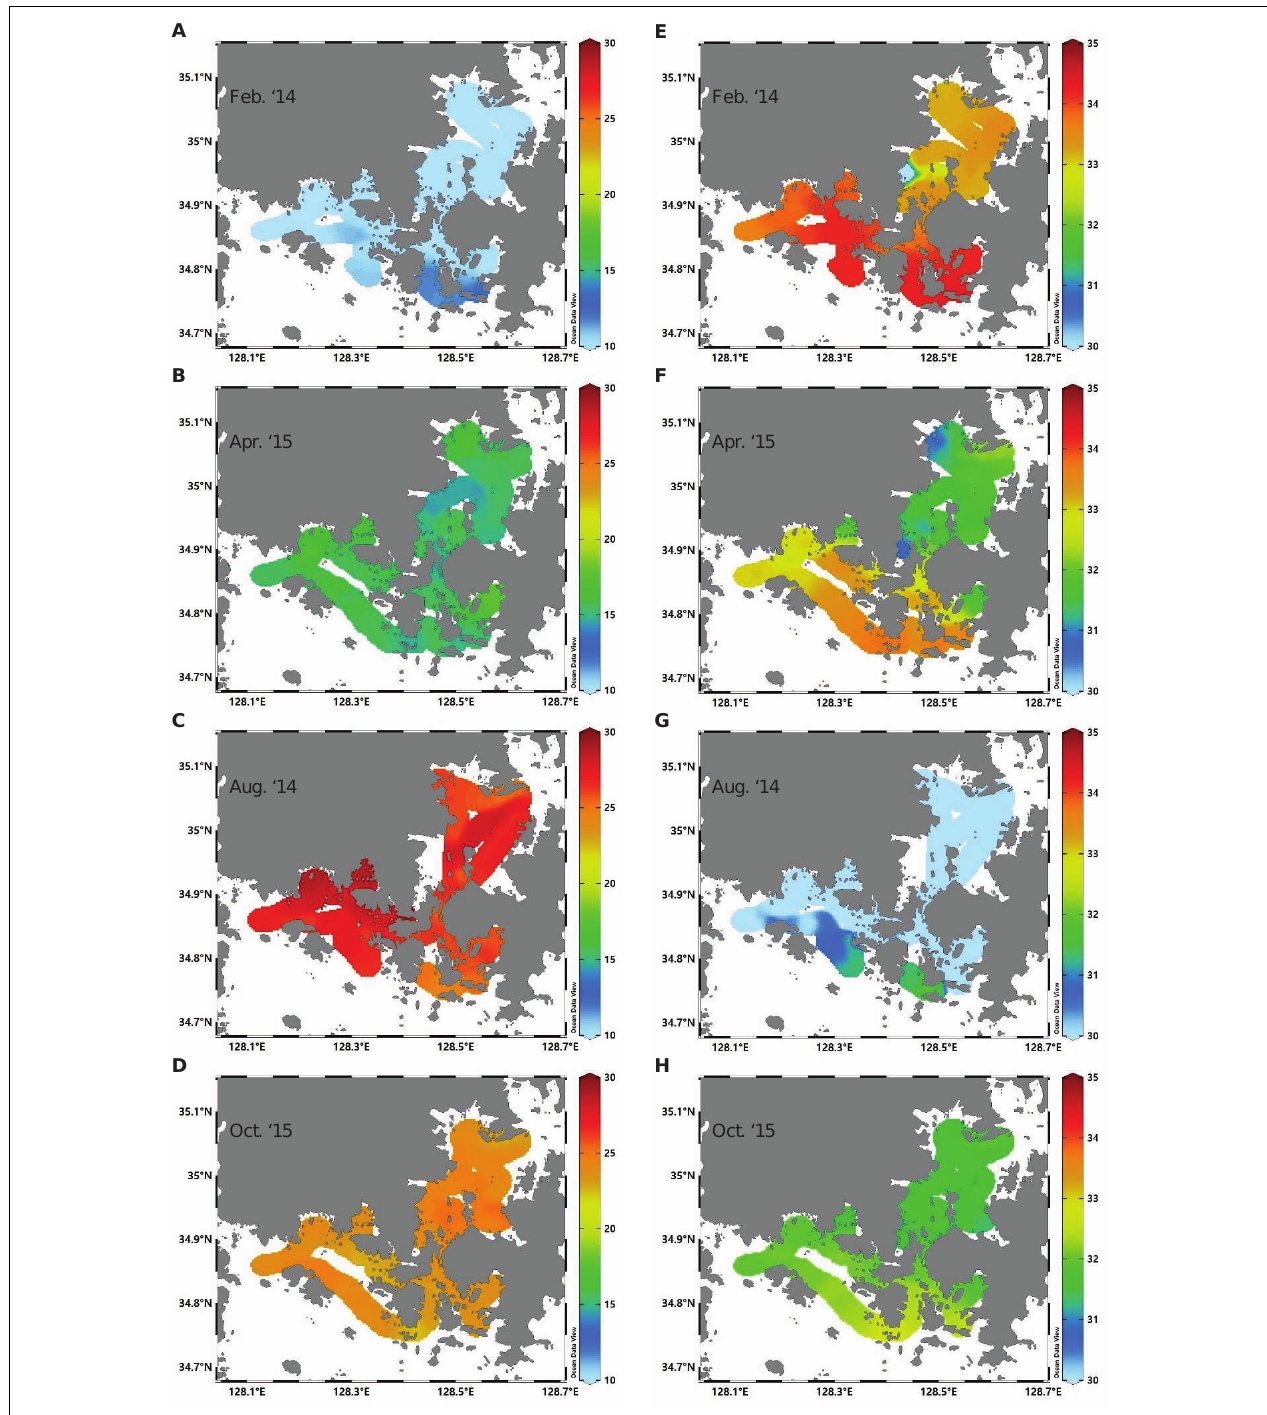
FIGURE 2 | Distributions of sea surface temperature ( ◦ C) (A–D) and salinity (E–H) for each survey.